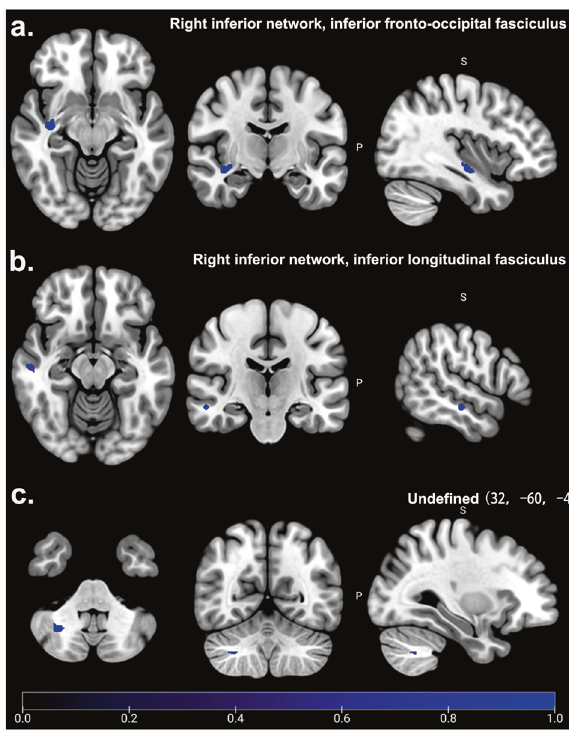
Fig. 3 Signi fi cant WM abnormalities between T2DM-CD and HCs. Patients with T2DM-CD showed the signi fi cant and consistent decreased FA (Blue) in right inferior network, inferior fronto-occipital fasciculus (IFOF.R) ( a ), right inferior network, inferior longitudinal fasciculus (ILF.R) ( b ), and unde fi ned area of cerebellum (32, − 60, − 42) ( c ) ( P < 0.005). No increased FA was found in T2DM-CD compared to HCs ( P =